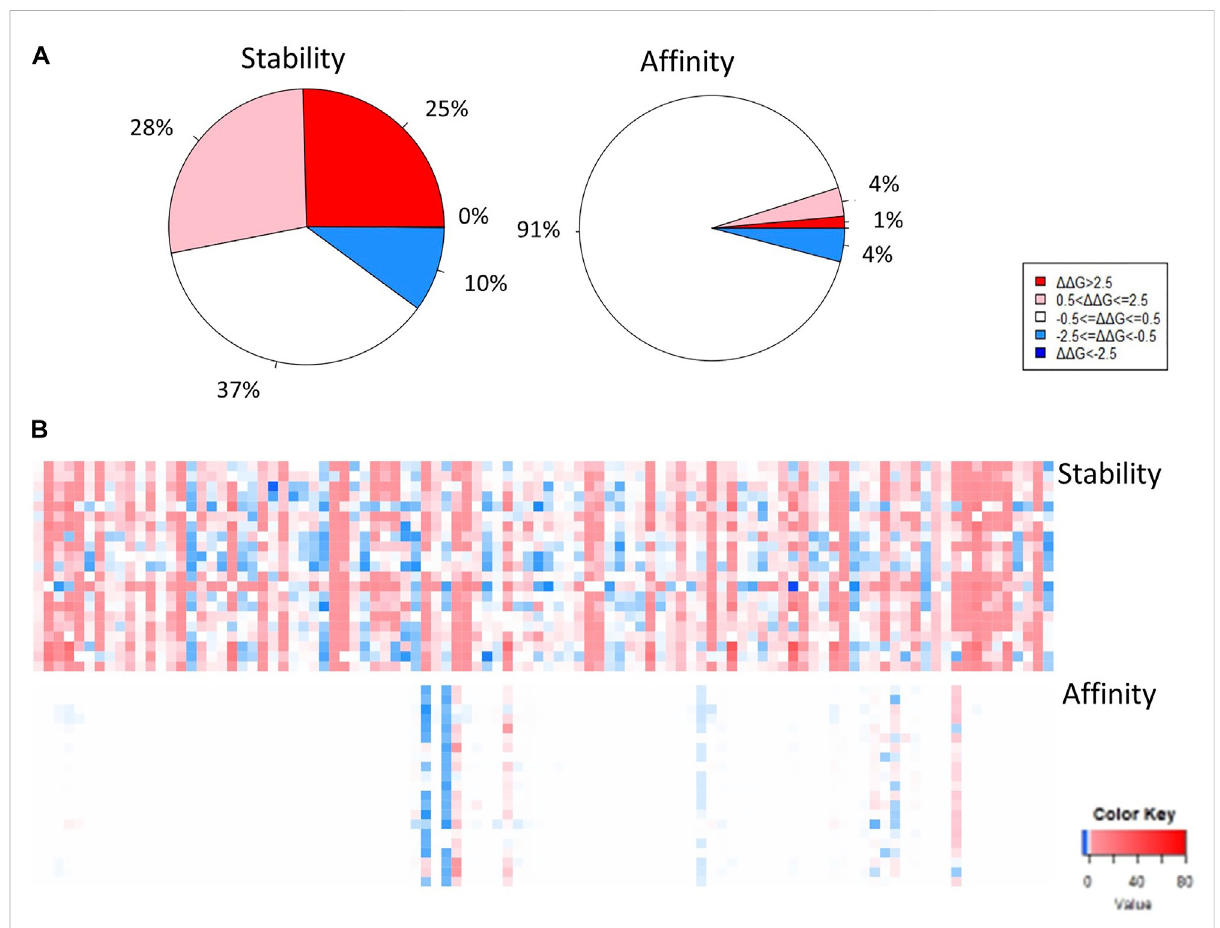
FIGURE 6 Stability and binding af fi nity of positions associated with reports of viral variants obtained from ViPR, displayed in pie charts (A) and in heatmaps (B)